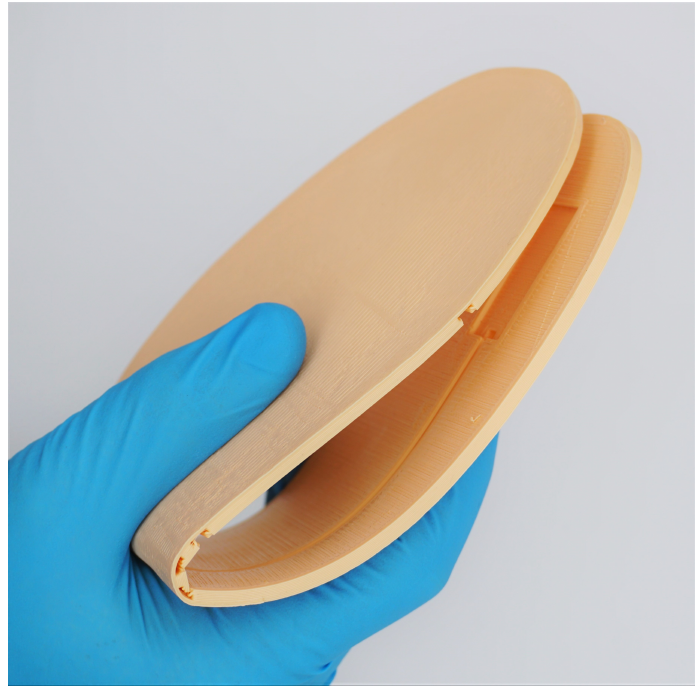
Figure 2. Demonstration of the flexibility of the 3D-printed insoles used in this study. The insoles were passivated by coating in a layer of 0.3 mm, 30 ◦ shore silicone (Translu- cent Silicone, Silex Silicones Ltd., Hampshire, UK) laser cut to the size of the insole and held in place with double-sided tape. Both the RTD sensors and the 3D-printed insole are flexi- ble, to improve comfort and reduce the risk of causing damage to participants, particularly in those with diabetes where neuropathy may have affected sensation at the